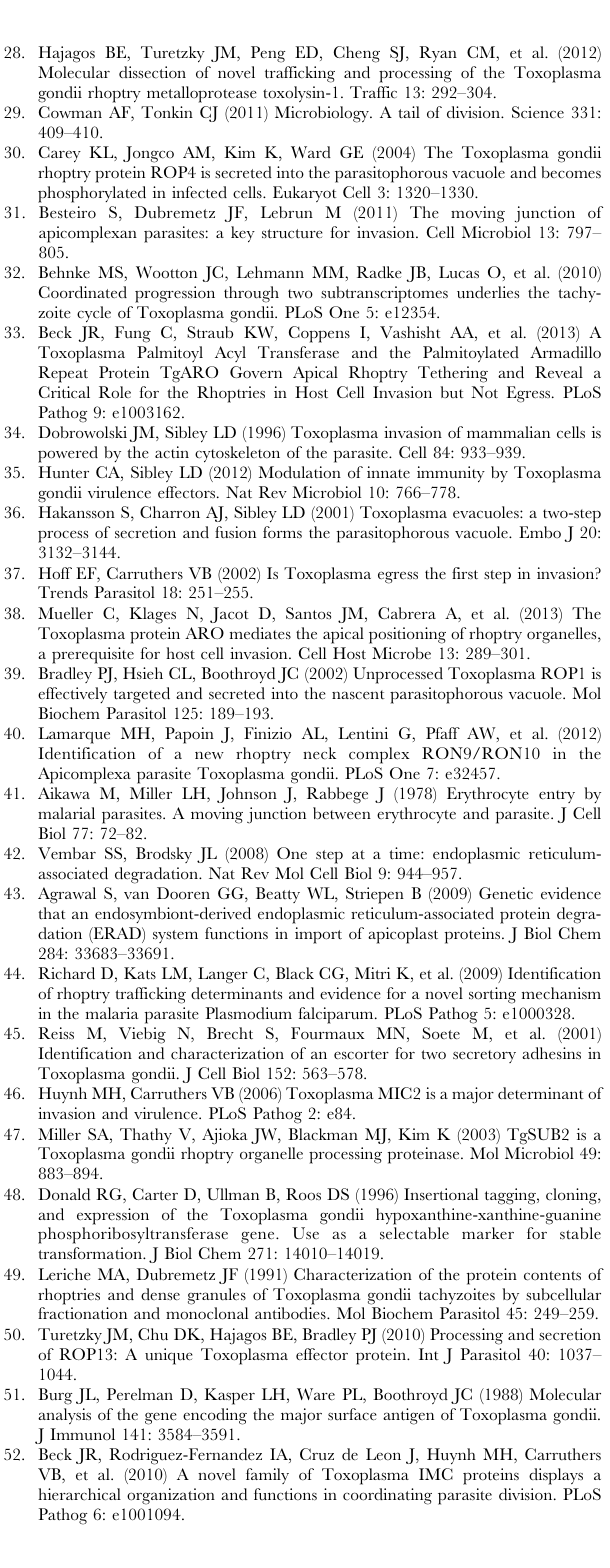
Table S1 Primers used in this study as discussed in text. Restriction sites and mutated or inserted bases are shown in